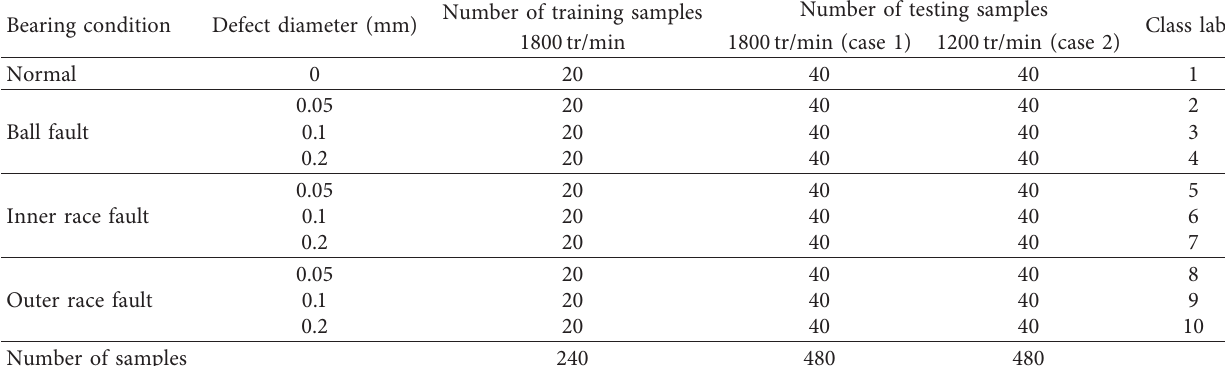
Table 17: The detailed information of the first group